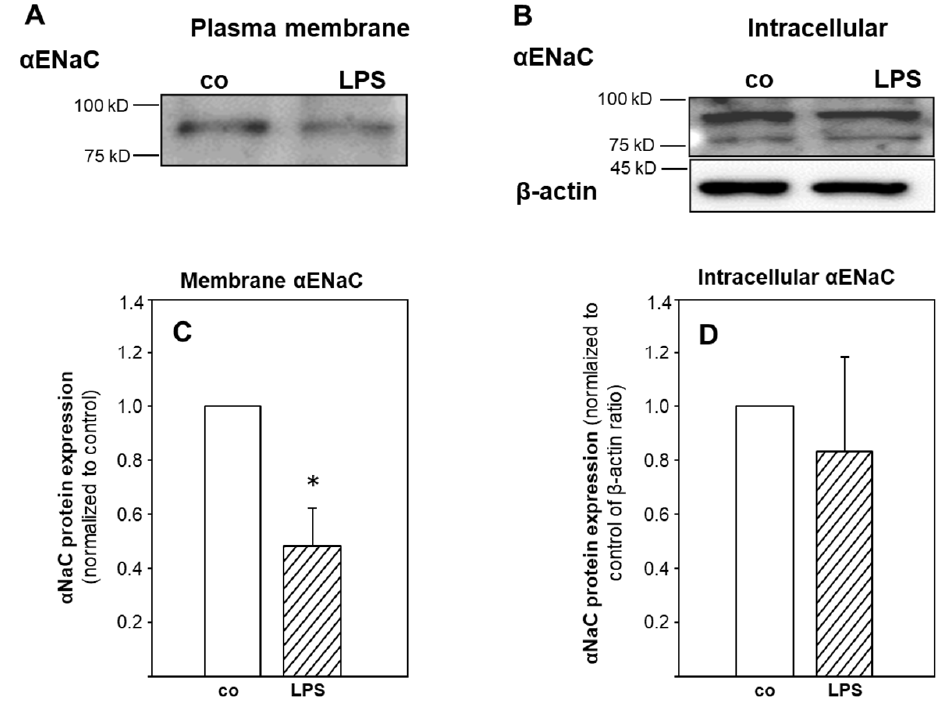
Figure 4. Plasma membrane and intracellular α ENaC protein expression of rA2 cells treated with LPS stimulated macrophage conditioned media (Figure S6). Conditioned media from LPS stimulated macrophages were kept on primary rA2 cell monolayers for 24 h. Biotinylated proteins represent the apical membrane fraction, non-biotinylated is considered intracellular. Representative immunoblots showing α ENaC ( A , C ) surface expression (biotinylated). ( B , D ) Intracellular α ENaC (non-biotinylated). β -actin was not detected in the surface (biotinylated) membrane fraction but only in the intracellular pool. * effect of LPS treated macrophage conditioned media, p = 0.03.